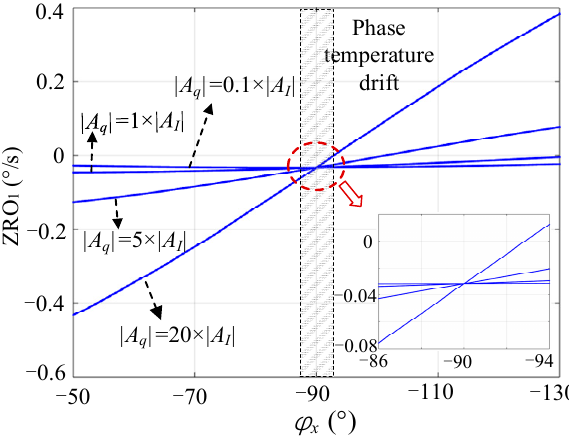
ϕ A ZRO and q on 1 .